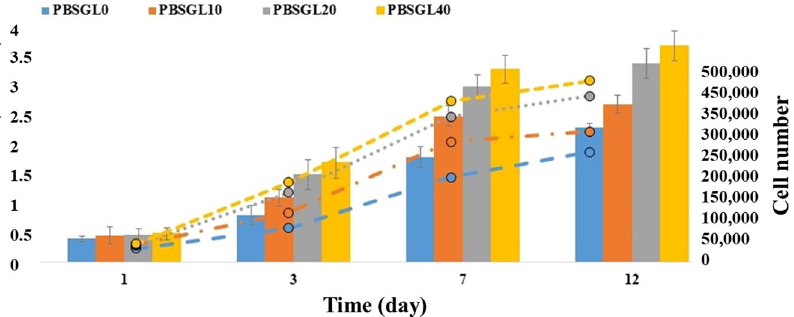
Figure 8. Metabolic activity (proliferation) of rabbit MSCs cultured on electrospun nanofibers submerged in basal medium at day 1, 3, 7, and 12. The secondary y axis shows the number of rabbit MSCs for colored dashed lines corresponding to each group. An asterisk denotes a statistically significant difference (P < 0.05) between the test and control group at each time point. The sample size selected was